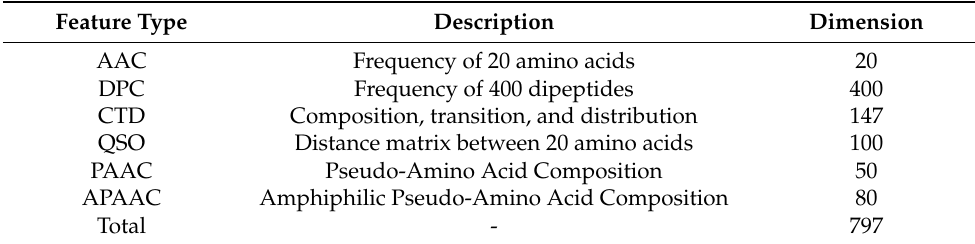
Table 3. Feature